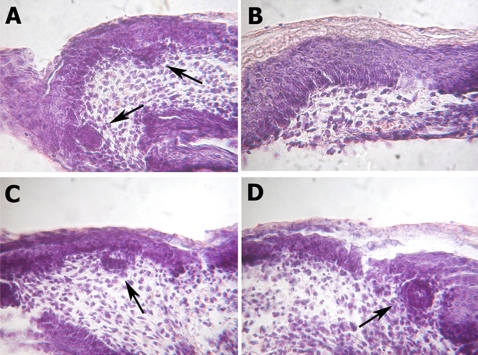
sFPR-3 and EGF reciprocal antagonism on hair follicle development.(A–D) sFPR-3 antagonizes the EGF effect rescuing the hair follicle formation in an organ culture of developing mouse skin. Ectoderm explants growth for 48 hours in control medium (A) or in control medium supplied with 7 µg/ml sFRP-3-HA (C), showing normal hair follicles differentiation (black arrows). (B) Ectoderm explants growth in organ culture in medium supplied with 100 ng/ml recombinant EGF for 48 hours, lacking hair follicle differentiation. (D) The co-treatment with EGF and sFPR-3 rescue the hair follicle formation (black arrow).